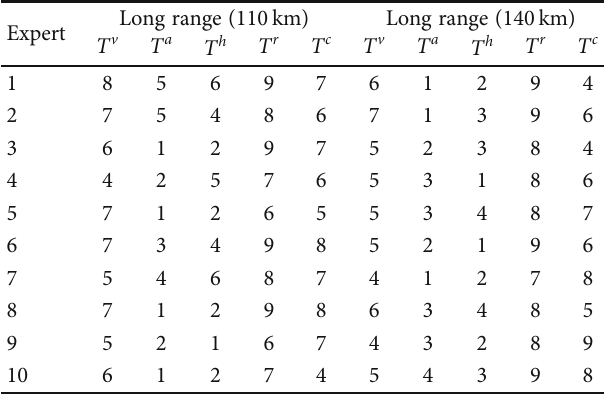
Table 3: Expert opinion evaluation form in long-range air combat